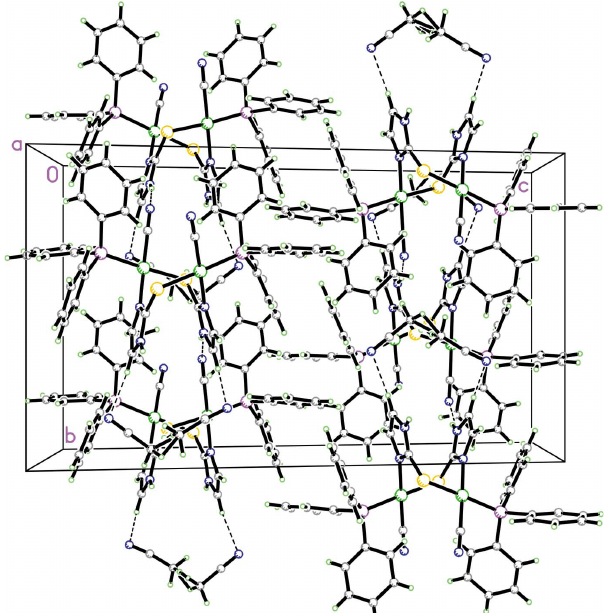
Figure 5 (7) 1 Diagram for 2 showing the packing viewed along the a- axis direction. N— H (cid:2)(cid:2)(cid:2) N hydrogen bonds and C—H (cid:2)(cid:2)(cid:2) N interactions involving the acetonitrile molecules are shown as dashed lines.